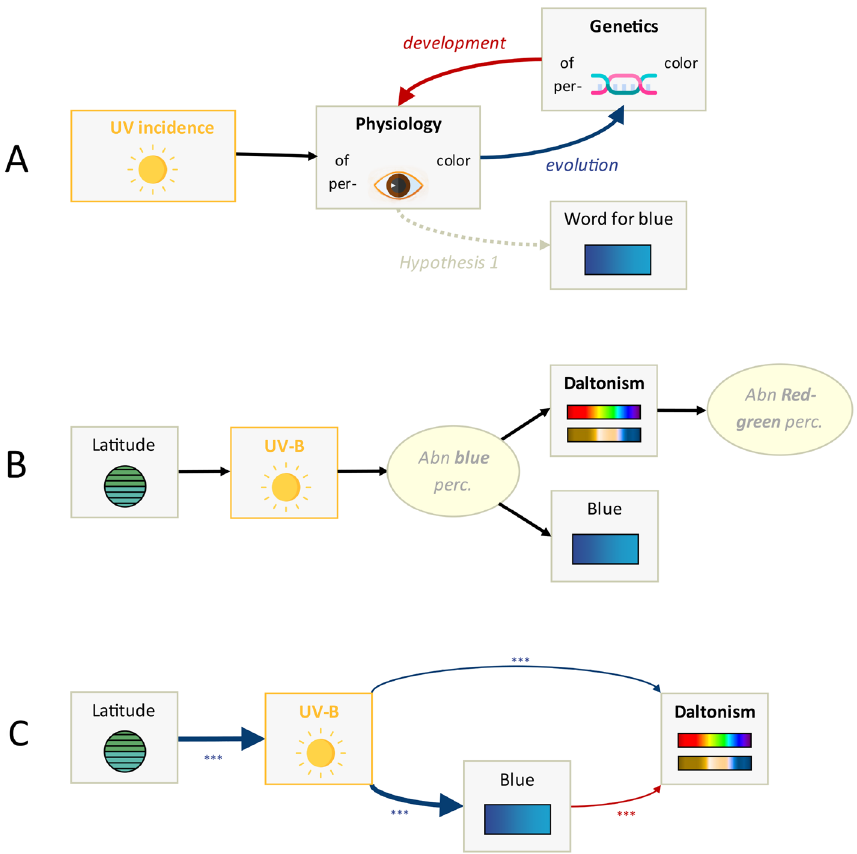
Figure 4. Derivation of path models for red-green abnormal color perception. (Panel A ): A direct graphical representation of the hypothesis that UV-B affects the unmeasured physiology of color perception during the lifetime of an individual which, in turn, affects the existence of a dedicated word for blue in the person’s language ( hypothesis 1 ). In addition, the physiology of color perception also drives an evolutionary interaction with alleles resulting in abnormal red/green color perception. (Panel B ): a Structural Equation Modelling diagram representation of Panel A with operationalized variables. (Panel C ): The latent variable ‘abn. blue perc.’, representing the unobserved abnormal color perception of blue, is indirectly measured by two indicators (‘daltonism’ and ‘blue’), while the latent ‘abn. red-green perc.’ (abnormal red/green color perception) is not of interest here. Therefore, we used ‘blue’ as a proxy for ‘abn. blue perc.’ and ignored ‘abn. red-green perc.’, leading to the path model shown here. Icons made by Freepik https:// www. freep ik. com from Flaticon https:// www. flati con.